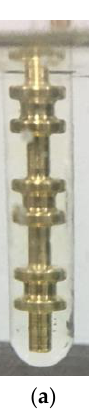
Figure 5. ( a ) The initial condition of the mineral oil inside the aging cell ( U = 0 kV); ( b ) gas bubble generation; ( c ) visual observation of PDs in oil; ( d ) gas bags between the metallic electrode disks ( U = 13 kV and T = 25